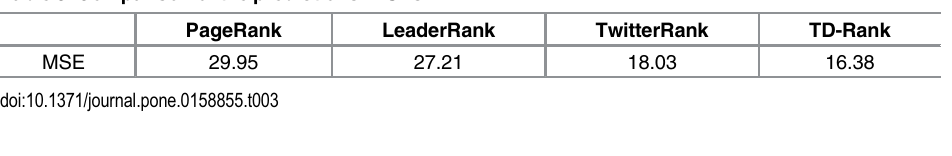
Table 3. Comparison of the predictions ’